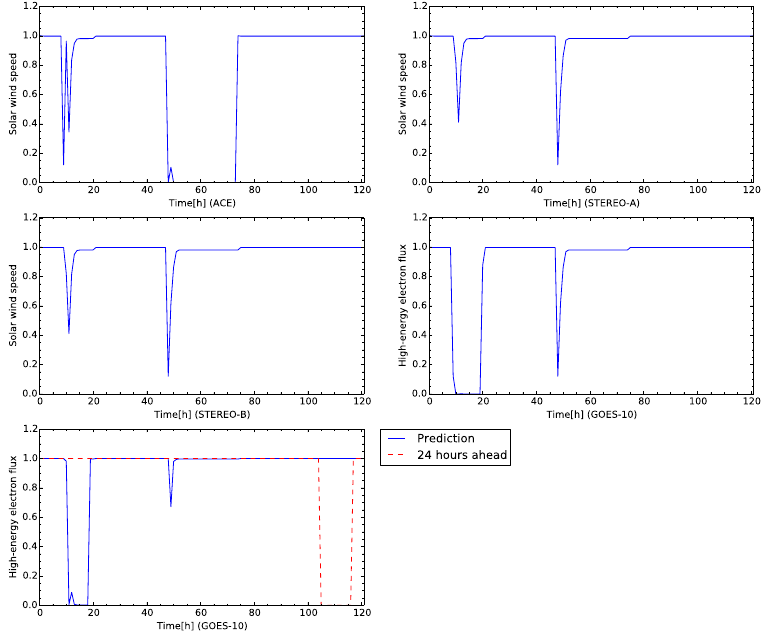
Figure 10. Time development of the credibility of each sensor for the test case shown in Figure 9. The satellite names are labeled in horizontal axes. The plots in the first row and the left one in the second row show the time development of the credibility for the solar wind speed. The right plot in the second row (in the third row) show the time development of the high-energy electron flux (high-energy electron flux 24 h ahead).